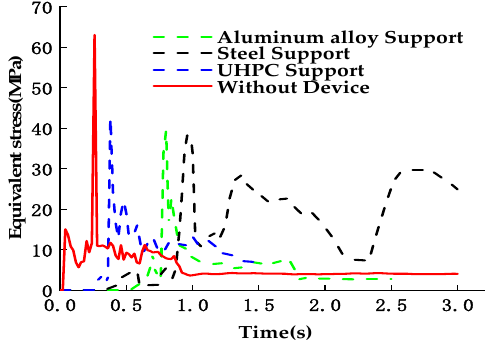
Figure 17. Equivalent stress curve of the pier impact area.